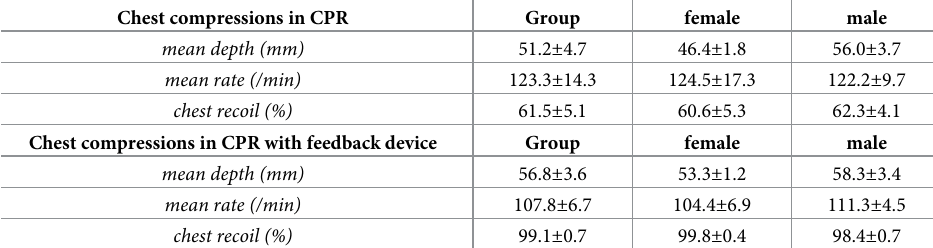
Table 3. Manual chest compression assessments with and without feedback